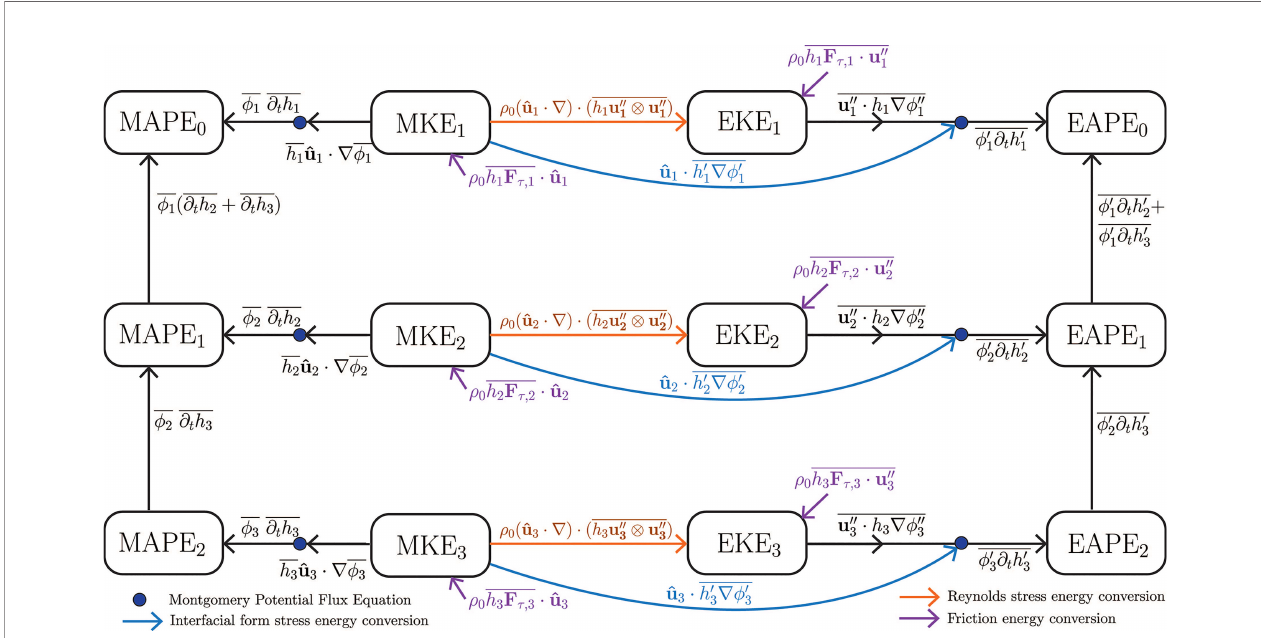
FIGURE 2 | Energy conversions in a three-layer model. Arrows are drawn between energy reservoirs according to the thickness-weighted energy cycle equations, with the direction according to the sign in the equation (noting energy transfers can occur both ways). The blue and orange arrows show the conversions associated with interfacial form stress and Reynolds stress, corresponding to baroclinic and barotropic instabilities respectively. The navy dots indicate where Montgomery potential fl ux equations were used, to link the energy conversion terms surrounding the dots. The purple arrows indicate the terms related to friction. Advective terms are not shown.